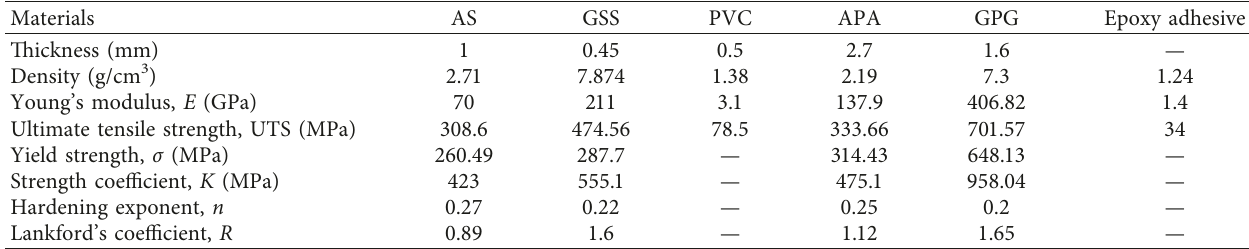
Table 1: Mechanical properties of AS, GSS, PVC, APA, and GPG.